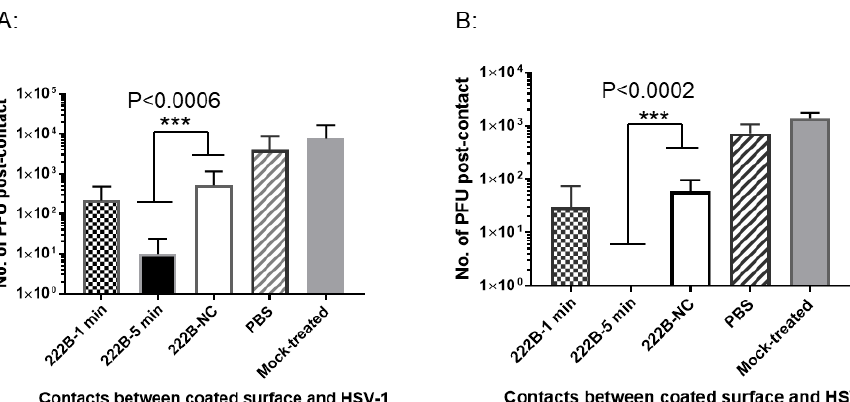
Figure 8. Contact inhibition against HSV-1 on the 222B coated plastic surface. The plastic surface was exposed to input viruses at ~2 × 10 4 PFU ( A ) or ~2 × 10 3 PFU ( B ) per well. The X-axis stands for contacts between coated surface and HSV-1; the Y-axis represents the number of PFU post-contact. The checked bar stands for direct contact between 222B and HSV-1 for 1 min (222B-1 min); the solid bar stands for direct contact between 222B and HSV-1 for 5 min (222B-5 min); the open bar stands for the no direct contact between HSV-1 and 222B (222B-NC), the striped bar stands for direct contact between PBS coated surface and HSV-1 for 5 min (PBS); and the gray bar stands for HSV-1 diluted in PBS directly (Untreated). The viruses eluted after direct contact were quantified by plaque assay as average PFU post 222B treatment ( n = 3). A significant statistical difference from the 222B-NC is marked with *** p < 0.0002 and p < 0.0006 (two-way ANOVA with Bonferroni post-test).